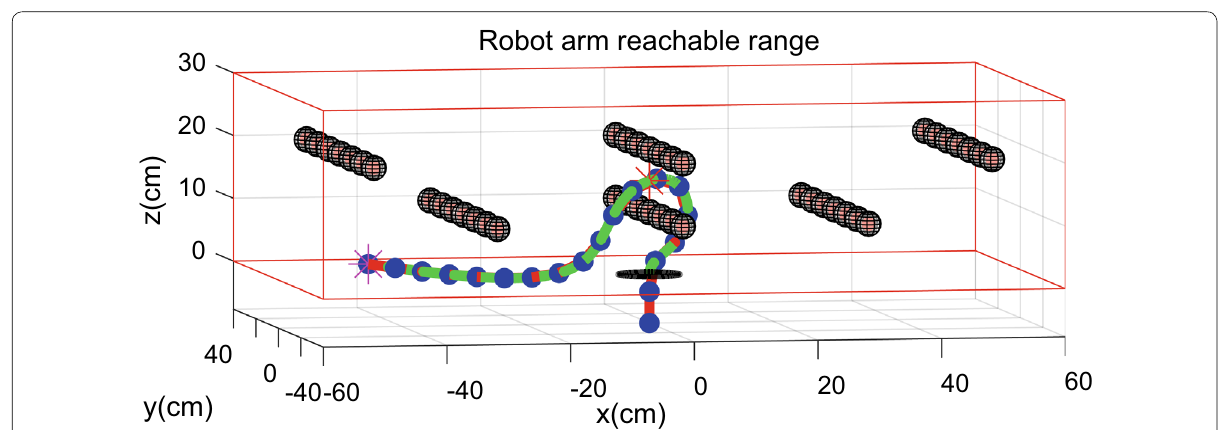
Figure 15 Rotational angles and base position